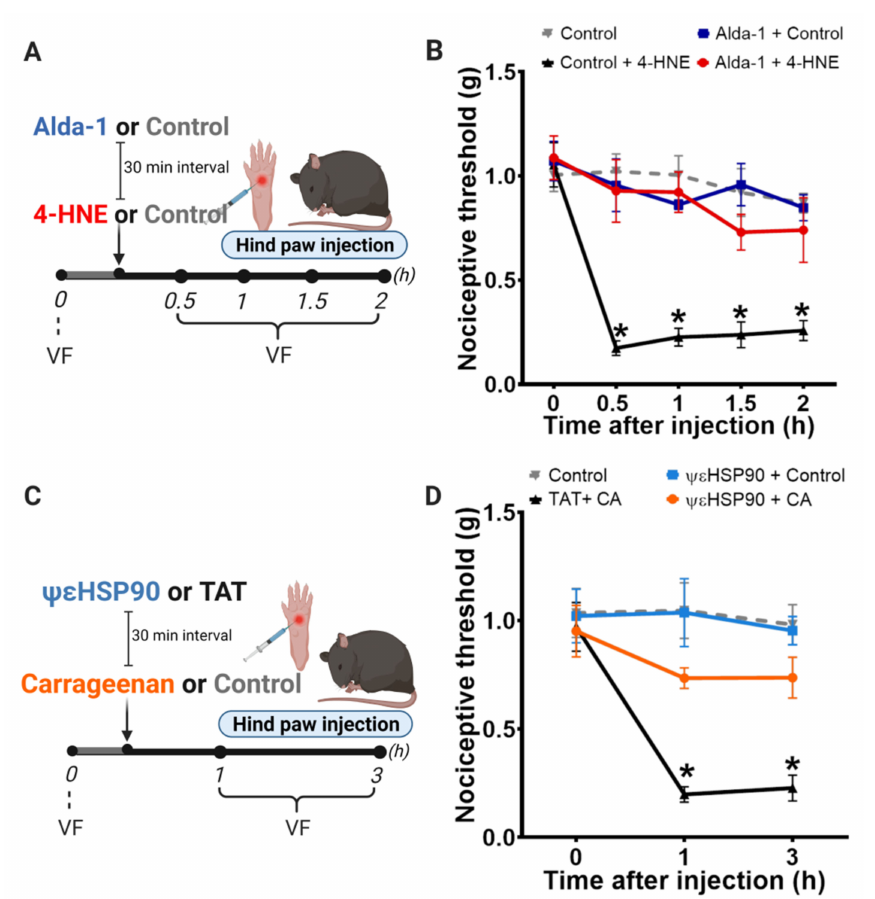
Figure 4. Activation of ALDH2 by Alda-1 prevents 4-HNE-induced nociception and by Ψ ε HSP90 pre- vents carrageenan-induced nociception. ( A ) Schematic panel of drug administration and von Frey fila- ment (VF). ( B ) Wild type animals received Alda-1 (10 mg/kg) s.c. 30 min before 4-HNE (60 nmol/paw) i.pl. ( C ) Schematic panel of drug administration and von Frey filament (VF) ( D ) Wild type animals received Ψ ε HSP90 or TAT (1 µ g/paw), i.pl., 30 min before carrageenan (CA) (100 µ g/paw)/paw) or saline i.pl. Error bars represent mean ± SEM; n = 8 per condition. Two-way analyses of